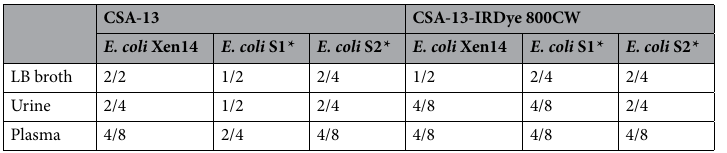
Table 2. Minimal inhibitory concentration and minimal bactericidal concentrations (MIC/MBC; µg/mL) of CSA-13 and CSA-13-IRDye800CW, against E. coli Xen14 and two clinical strains of uropathogenic E. coli (S1 and S2) isolated from patients with urinary tract infections in LB broth, urine and plasma. *Clinical strain.